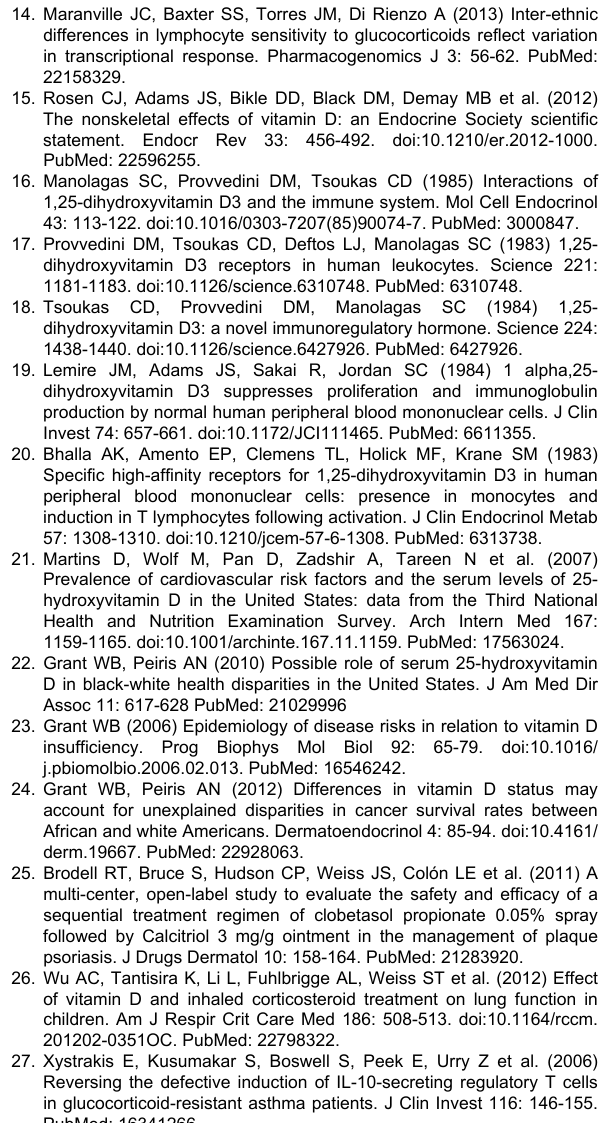
Table S7. Network analysis of upregulated genes only in response to vitamin D treatment at 24 hours.